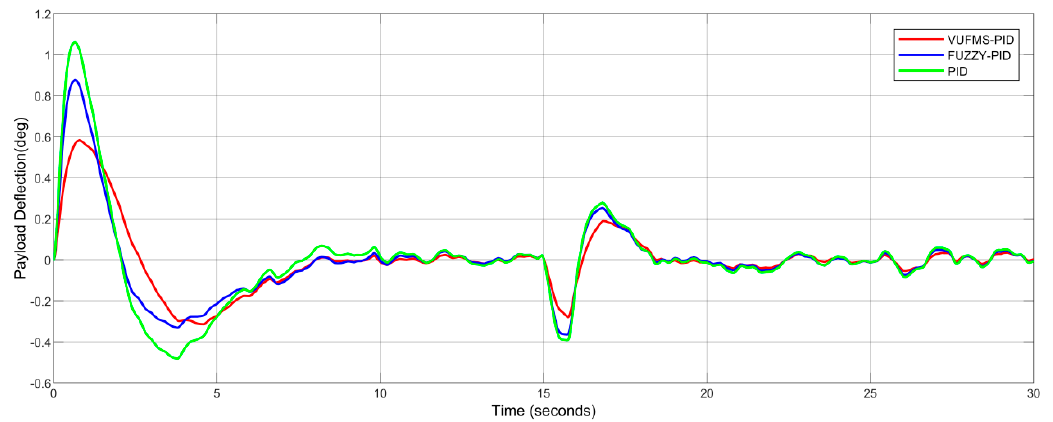
Figure 17. Trolley’s position using VUFMS-PID, FUZZY-PID and PID controller under working condition 2 with a crosswind and white noise.